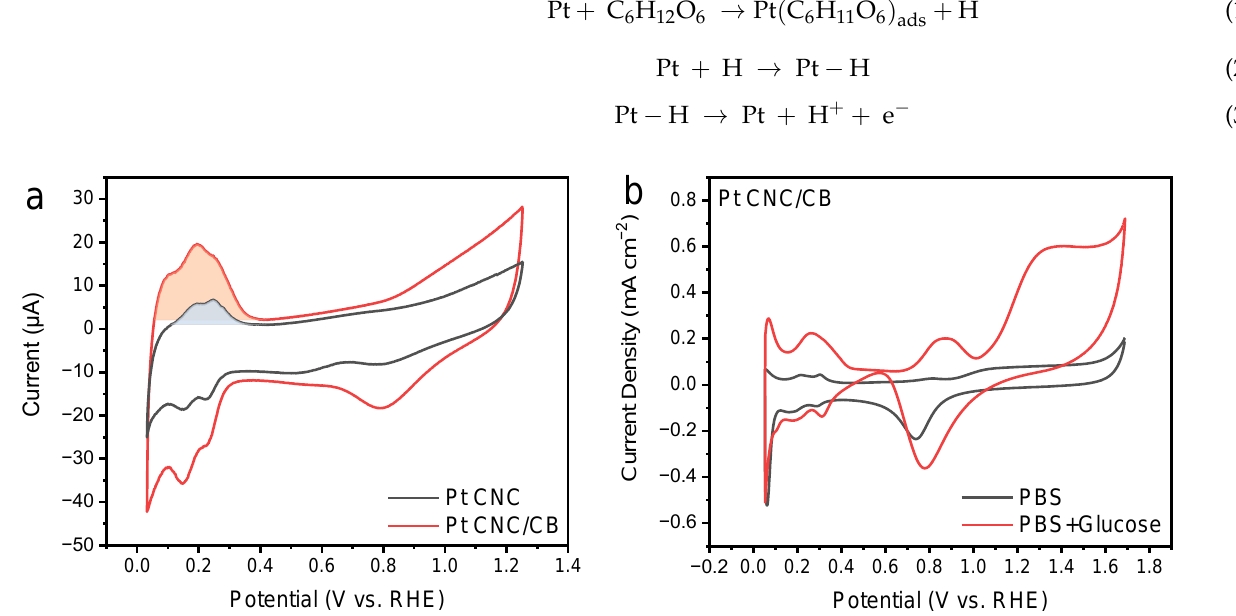
Figure 4. CV curves of Pt CNC/CB and Pt CNC in a 0.5 M H 2 SO 4 solution ( a ); CV curves of Pt CNC/CB in 0.1 M PBS (pH 7.4) solution with and without 50 mM glucose ( b